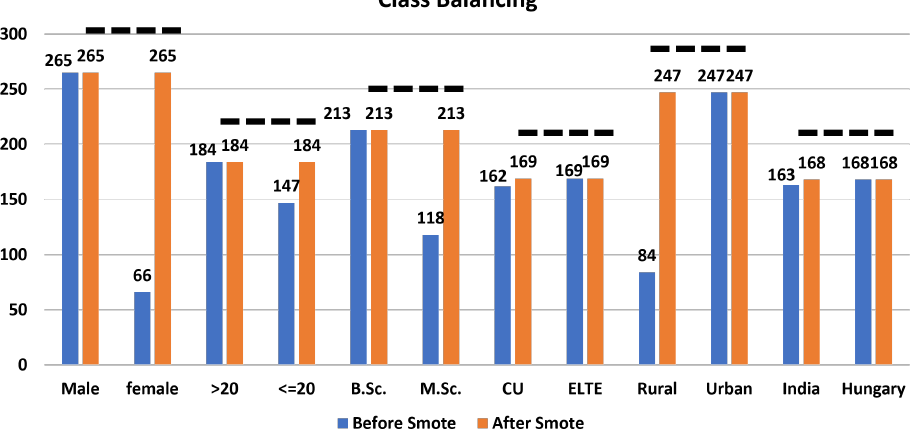
Figure 2. Class balancing of target features using